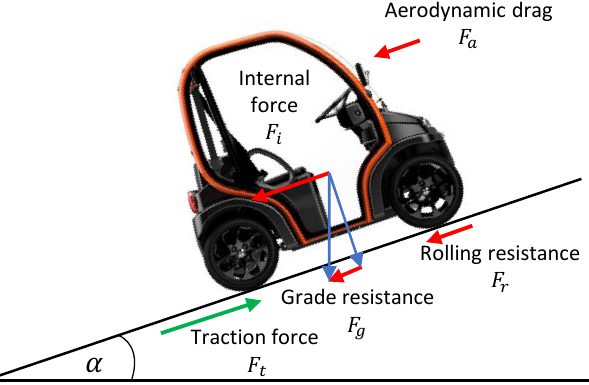
Figure 6. Driving